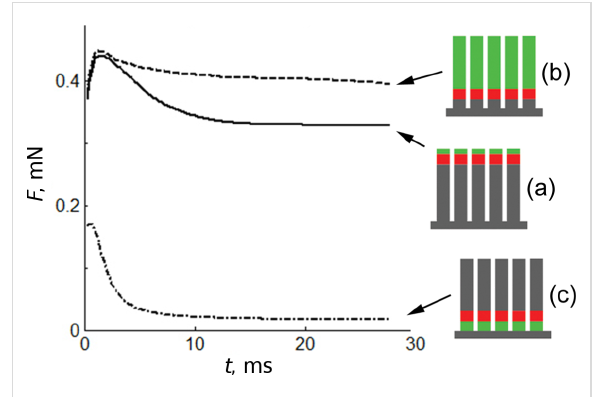
Figure 4: Time depending vertical forces developed during attach- ment of initially unperturbed systems to the hard surface. Solid, dashed and dash-dotted lines correspond to the cases (a), (b) and (c) of previous figures, respectively.